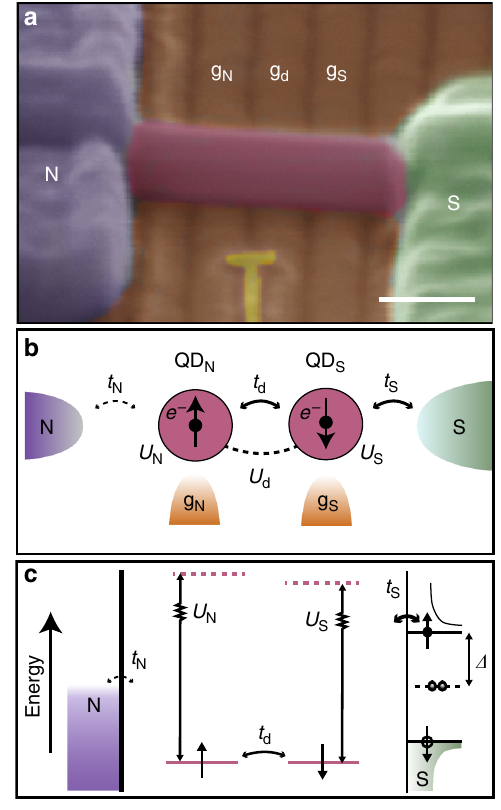
Fig. 1 Device layout. a False colored scanning electron micrograph of Device A showing a normal (N) — InAs nanowire — superconductor (S) device, where a double dot is de fi ned by appropriate voltages on the bottom gates. The yellow fl oating gate intended for charge sensing by a nearby quantum dot is not used. The scale bar corresponds to 100 nm. b Schematic of a with couplings t N and t S , respectively. The electrostatic potentials on the two dots are controlled by gates g N and g S , respectively, while the